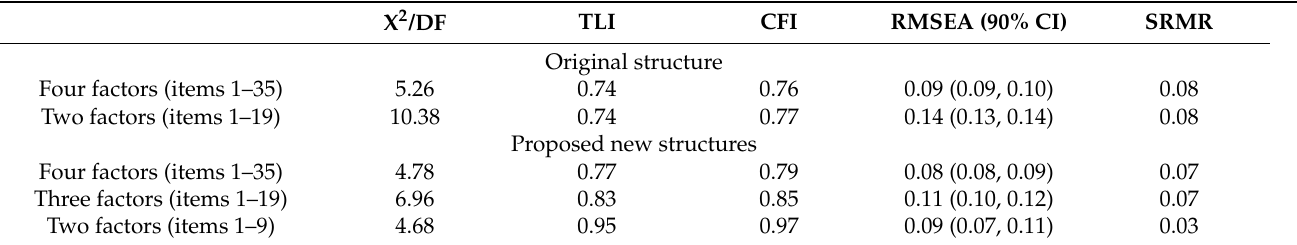
Table 4. Model fit indices for